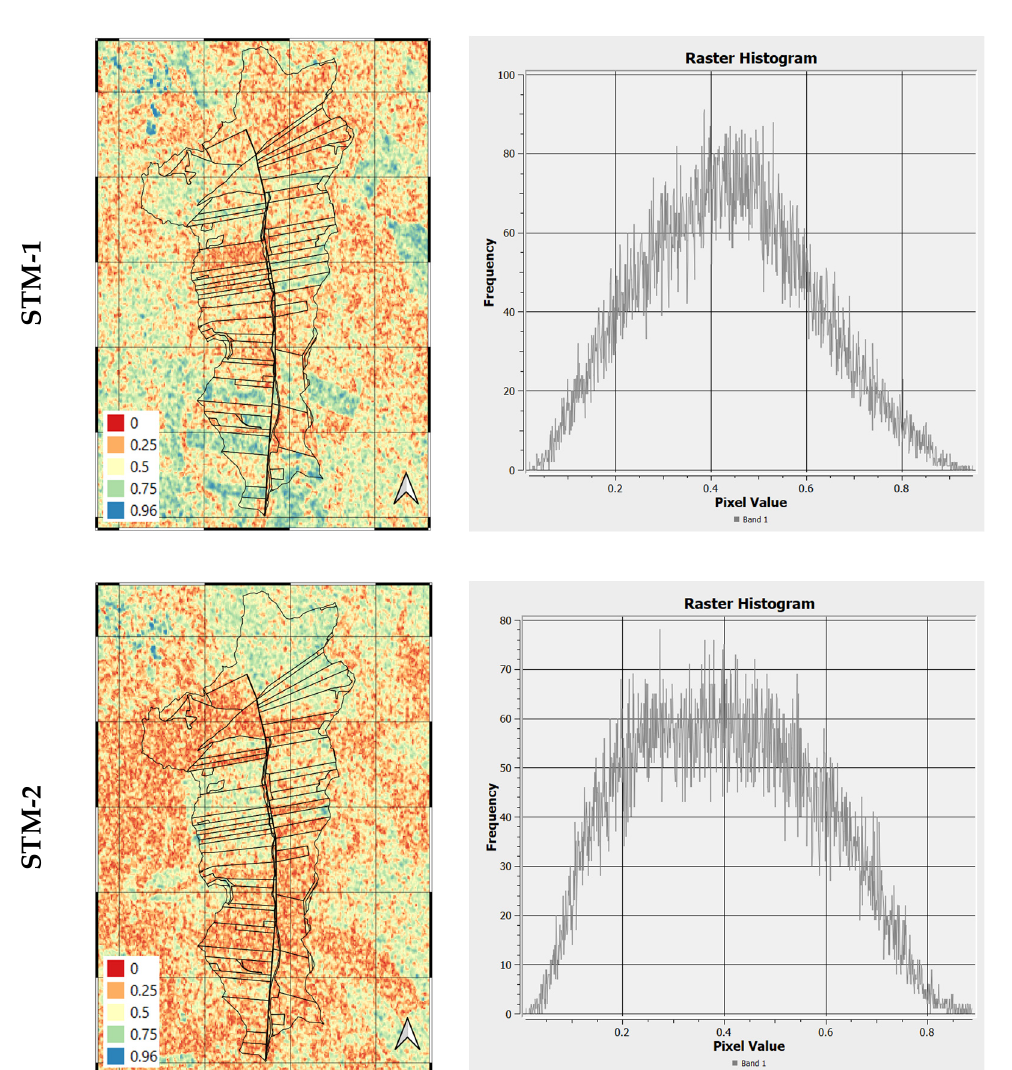
Figure 10. Coherence raster between acquisitions in scenarios STM-1 and STM-2. The histogram shows only values of the part of the raster inside the basin. Zebra frame segments of 1 km.